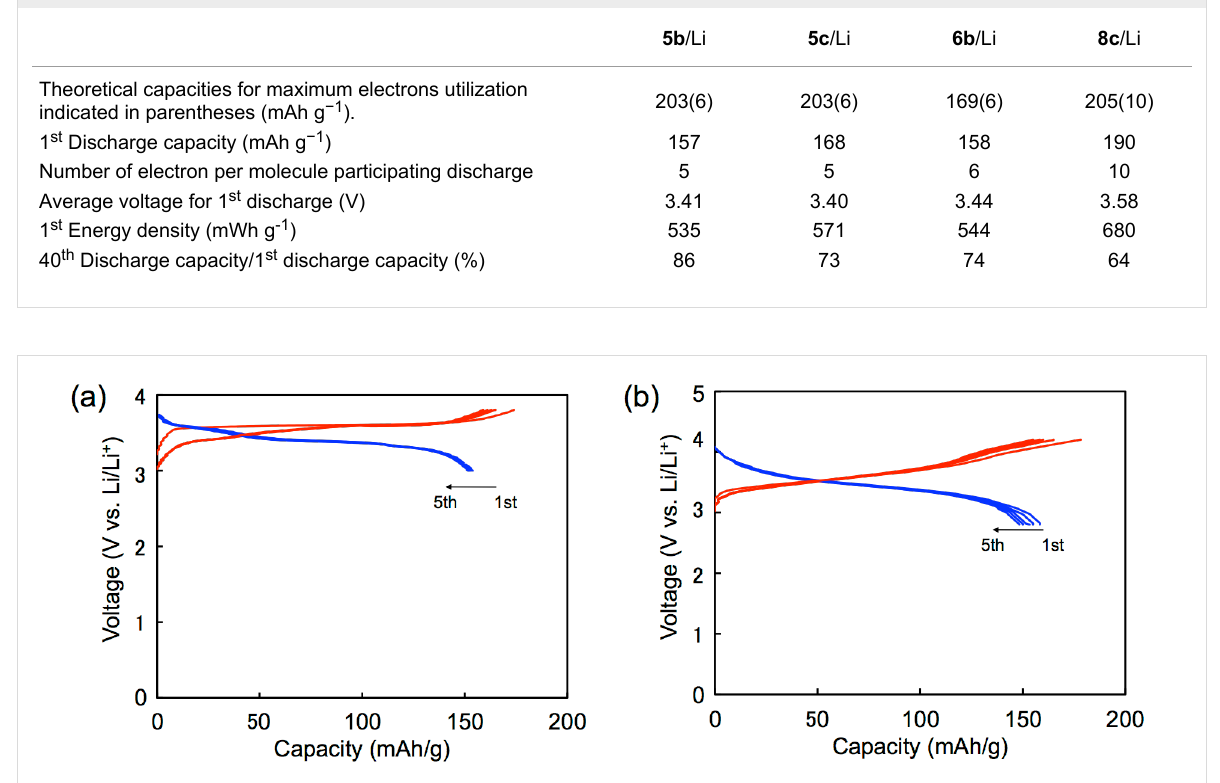
Table 3: Charge–discharge parameters for the rechargeable batteries using 5 , 6 and 8 .